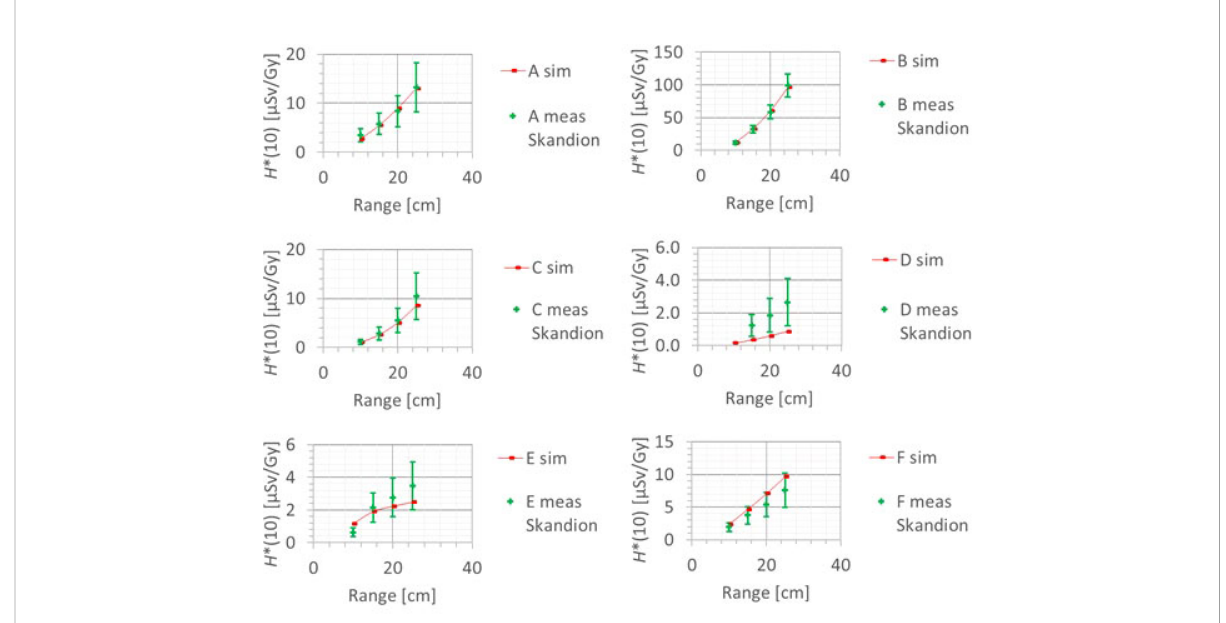
FIGURE 11 Plots of the variation of the simulated H*(10) (red bars) and measured H*(10) (green crosses) as a function of the range for a fi eld size of 10 cm by 10 cm and a modulation width of 5 cm without a range shifter for the different positions.